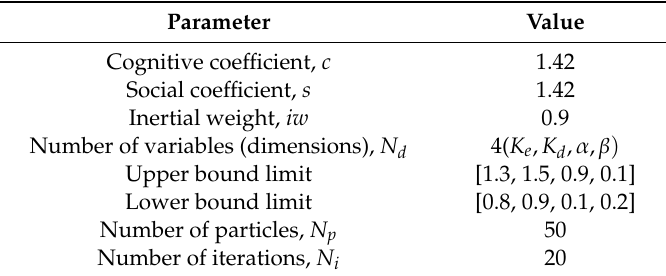
Table 3. Particle swarm optimization (PSO)